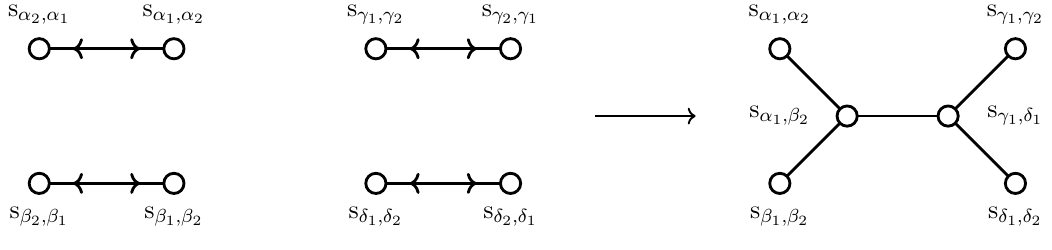
(cid:16) (cid:17) A (1) (cid:2) A (1) (cid:2) A (1) (cid:2) A (1) to W ( D (1) 1 1 1 1